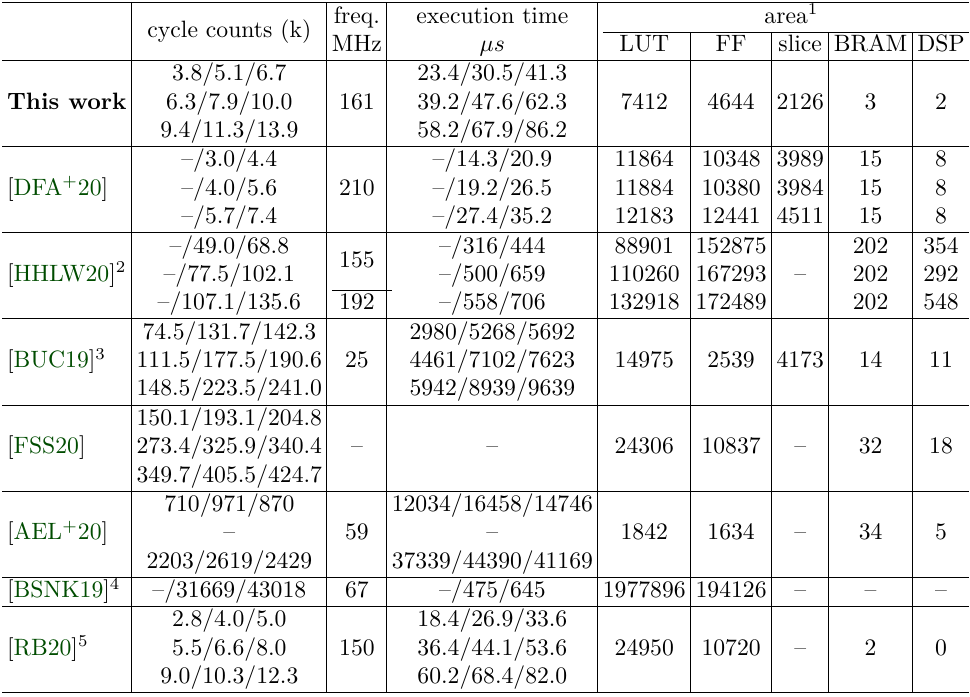
Table 5: Comparison with related works. Designs are deployed on Xilinx Artix-7 device unless otherwise specified. Three rows correspond to cases when k takes 2,3,4 respec- tively. The slashes denote separation of three phases: key generation, encapsulation and